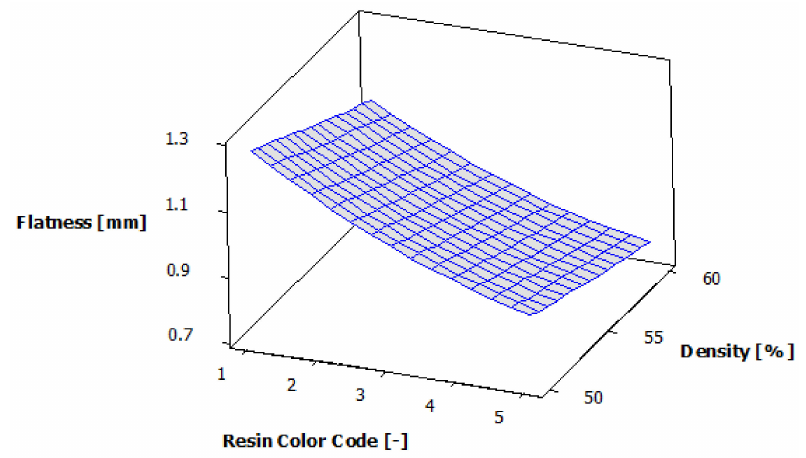
Figure 13. Estimated response surface for flatness.